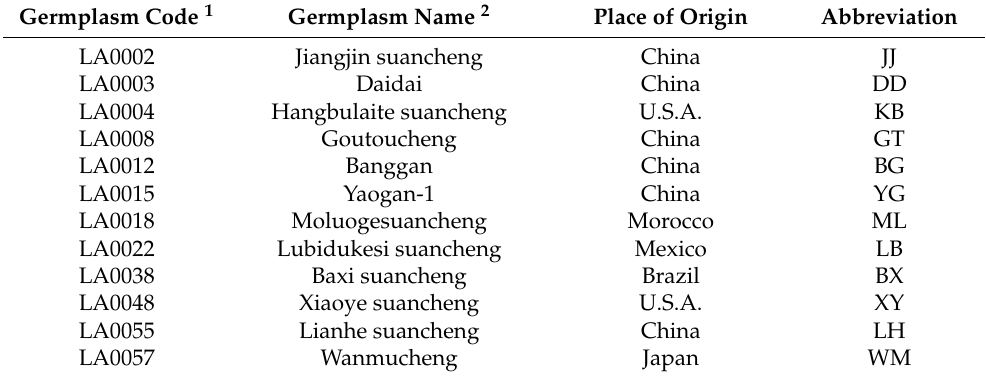
Table 1. List of sour orange resources collected in Citrus Research Institute,